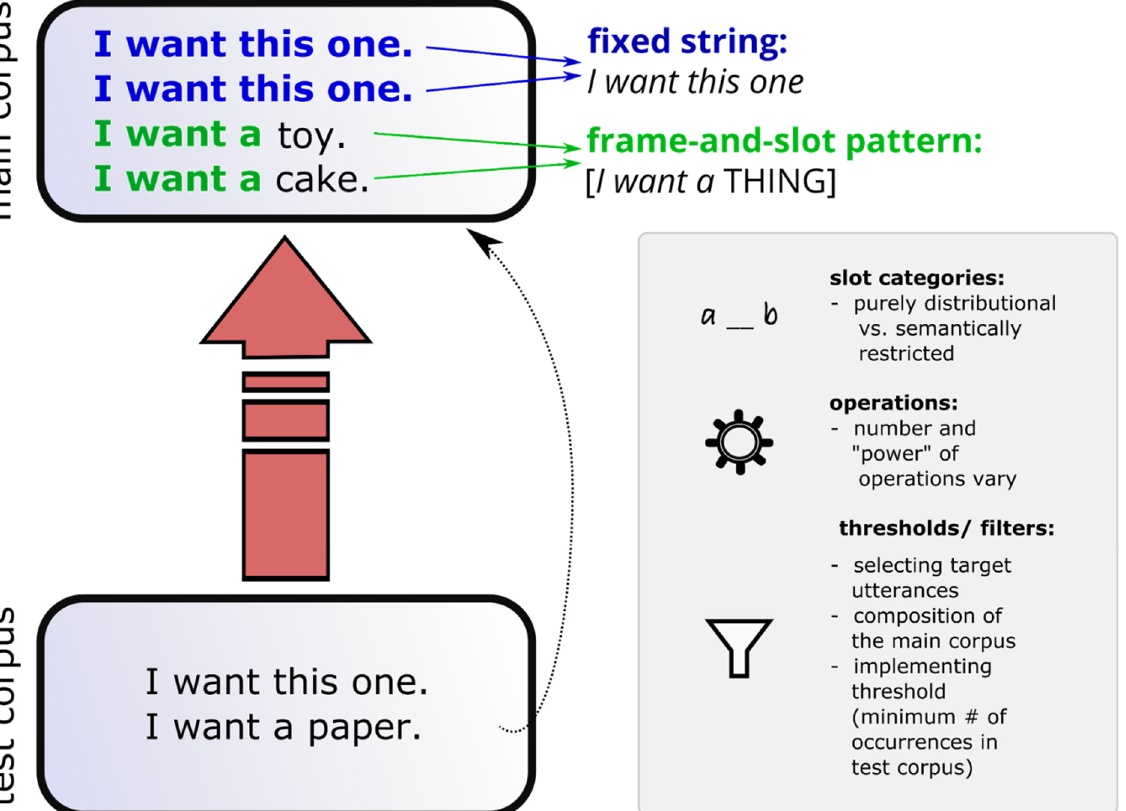
Figure 1. The TB method, illustrated with (constructed) examples from D ą browska and Lieven (2005). The grey box shows the “parameters” along which different implementations of the TB method vary. Figure from Hartmann et al. (2021), CC-BY 4.0.